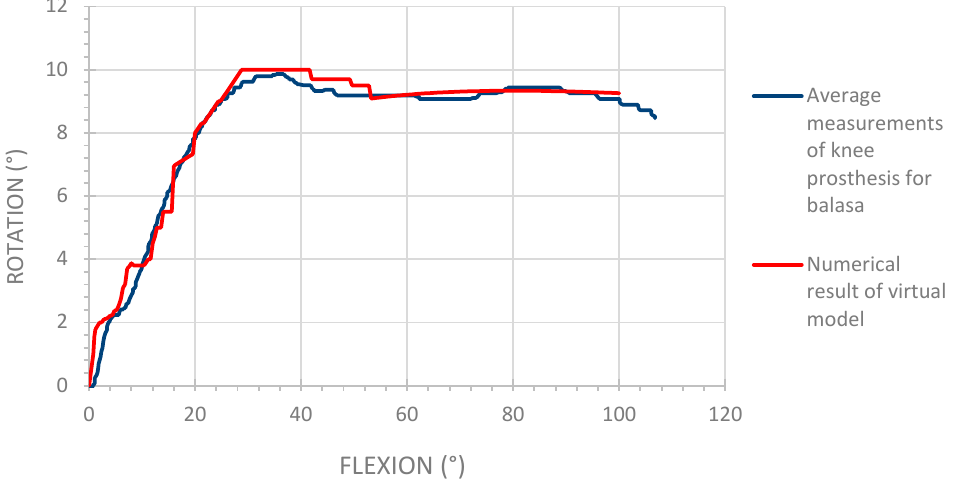
Figure 19. Verification results of our virtual model with the prosthesis developed with the test machine.